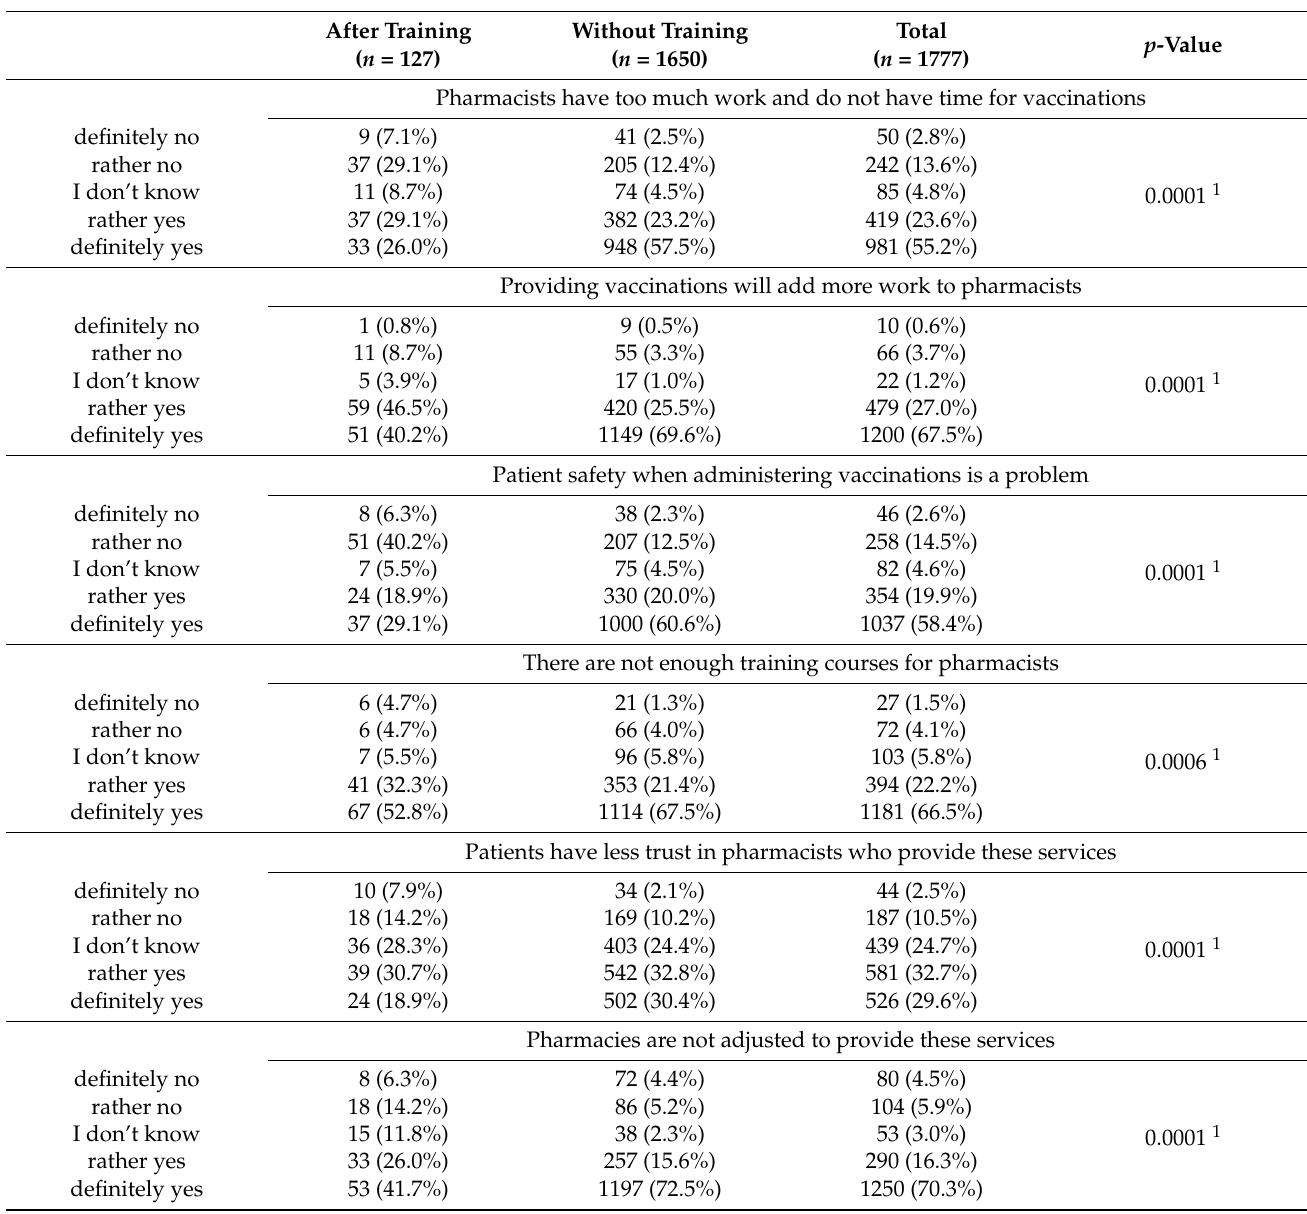
Table 3. Barriers affecting the readiness to provide vaccination services by the pharmacists participating and not participating in the Pharmacists Without Borders